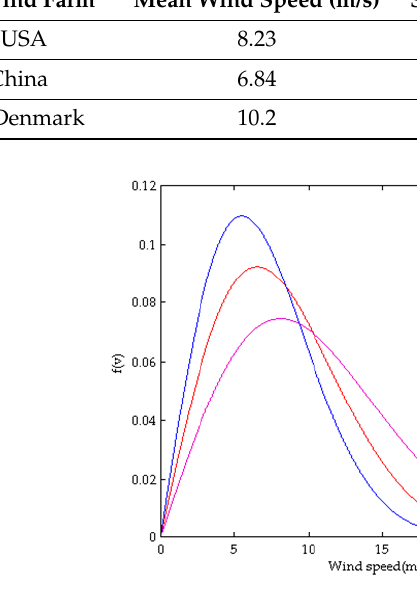
Figure 3. Weibull probability distribution functions of three cases at reference hub height H 0